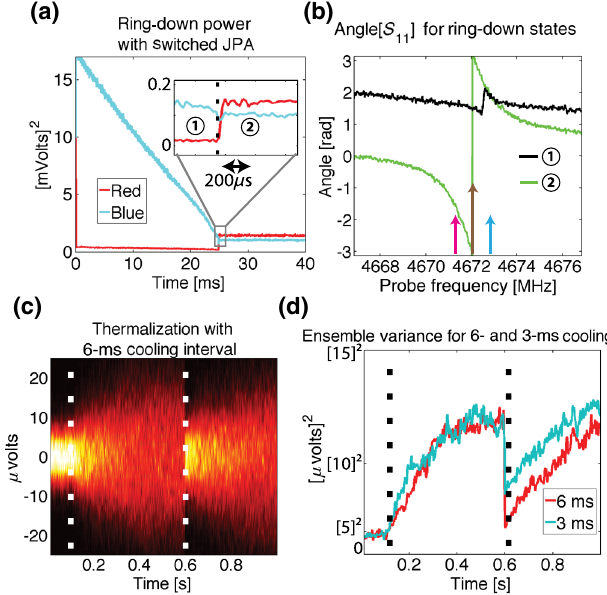
FIG. 4. Dynamic JPA control. (a) Red and blue sideband powers ringing down from a very high coherent amplitude. From 0–25 ms (25–40 ms), the network is in state 1 (state 2); see Figs. 3(d) and 4(b). Inset: detail of the network transition, depicted with a 25-kHz bandwidth. (b) Microwave probe S 11 measurements for the network states employed in (a), with arrows indicating coupling tone and sidebands. (c) Switched rethermalization of a cooled MO. At 100 ms, the JPA is tuned (cooling) state to the (cid:2) ¼ (cid:2) (bath- from the (cid:2) (cid:11) (cid:2) 0 0 thermalizing) state. At 600 ms, the JPA is switched to the cooling state for 6 ms only. The plot represents the ensemble distribution of blue sideband amplitudes in time for 300 trials. (d) Sideband- amplitude variance for 6 ms ¼ 2 = (cid:2) and 3 ms ¼ 1 = (cid:2) cooling- interval experiment